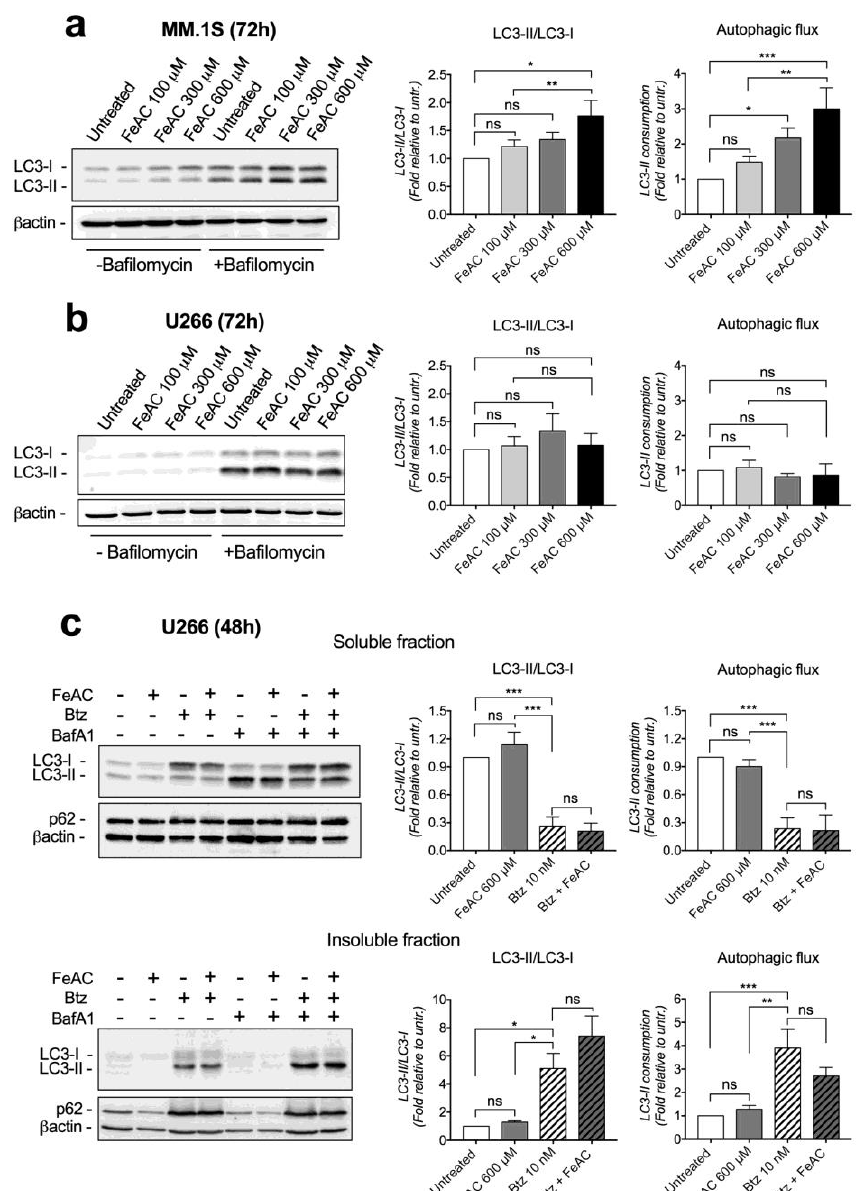
Figure 3. Long time iron exposure increases autophagy in MM.1S cells but does not increase autophagy response after proteasome inhibition. ( a , b ) LC3 protein levels measured in MM cell lines treated with titrated doses of ferric ammonium citrate (FeAC) for 72 h. ( c ) LC3 and p62 protein levels in soluble and insoluble protein extracts fractions obtained from U266 cells treated with 600 µ M FeAC or 10 nM bortezomib (Btz) or combination for 48 h. Where indicated, bafilomycin (BafA1) was added at 75 nM for the last 8 h of incubation. The rate of autophagosome formation was estimated by considering LC3-II / LC3-I ratio in bafilomycin treated cells. Autophagic flux was considered as the di ff erence of LC3-II protein between bafilomycin-treated and untreated cells. Left panels: representative western blots. Right panels: densitometry summaries of at least 3 independent replicates for each analysis. Values are shown as mean ± standard errors. Statistical di ff erences were determined by Tukey post-ANOVA test. ns: non-statistically significant. * p < 0.05; ** p < 0.01. *** p < 0.001. Original uncropped blots of western blotting showed in Figure S7.